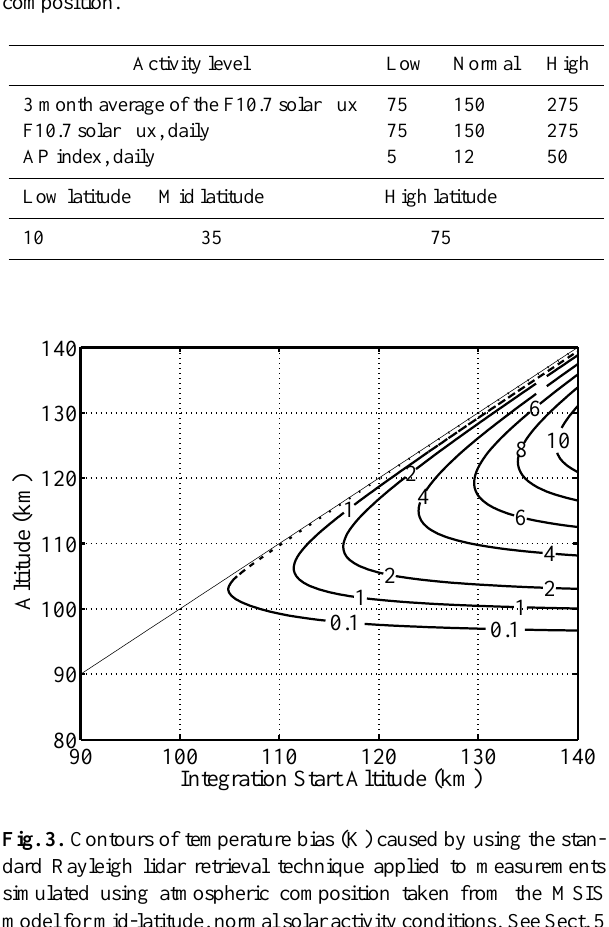
Table 2. MSIS input parameters used for simulating atmospheric composition.